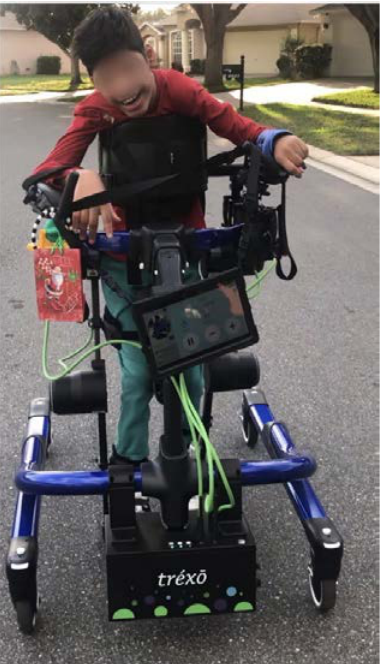
Figure 1. A child using the Trexo device in the community. The smile is meaningful as it represents the positive experiences reported by families. This photo was shared with